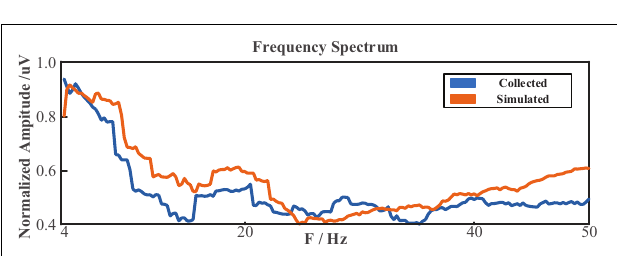
FIGURE 17 | The frequency spectrum of simulated scalp EEGs and real collected data.